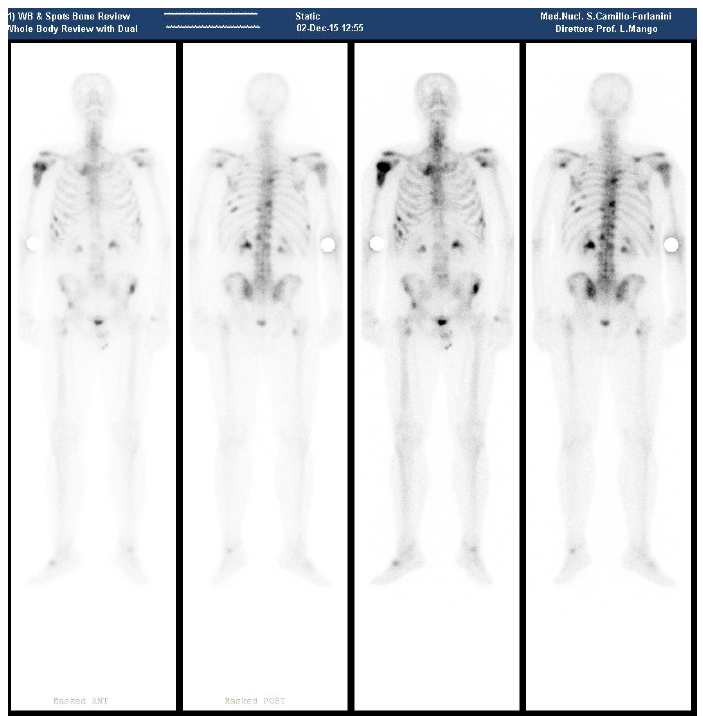
Figure 1. (December 2015—Bone scan pre 223 RaCl 2 Therapy, showing several metastatic sites as described in the text).